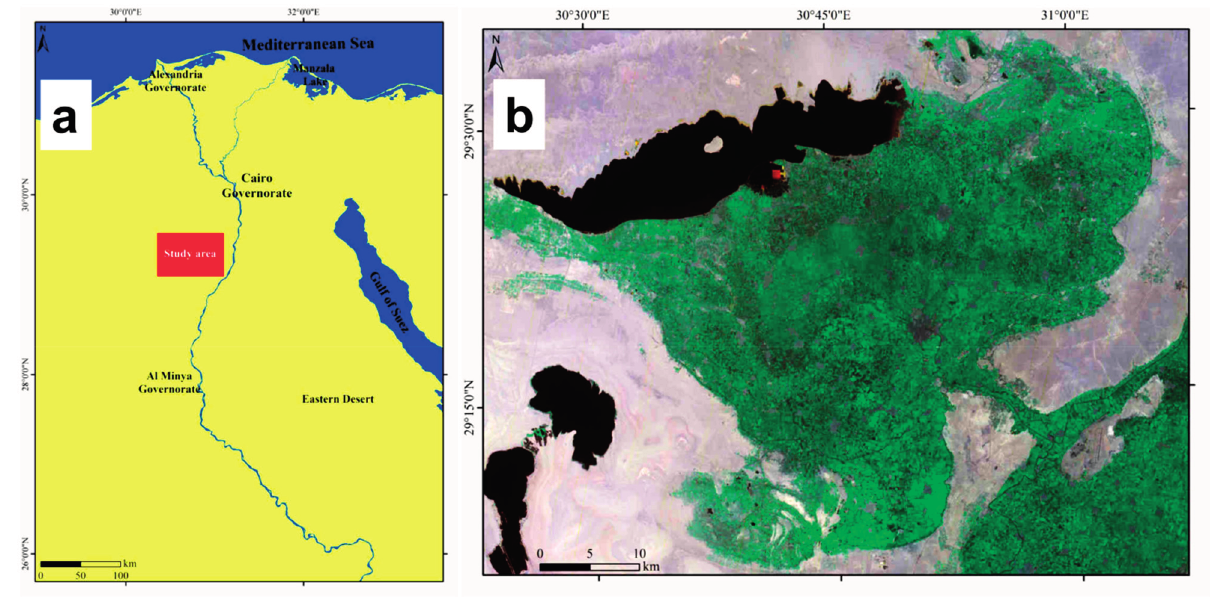
Figure 3. Location map of the ( a ) El-Fayoum depression and ( b ) satellite image (Landsat ETM 2011).